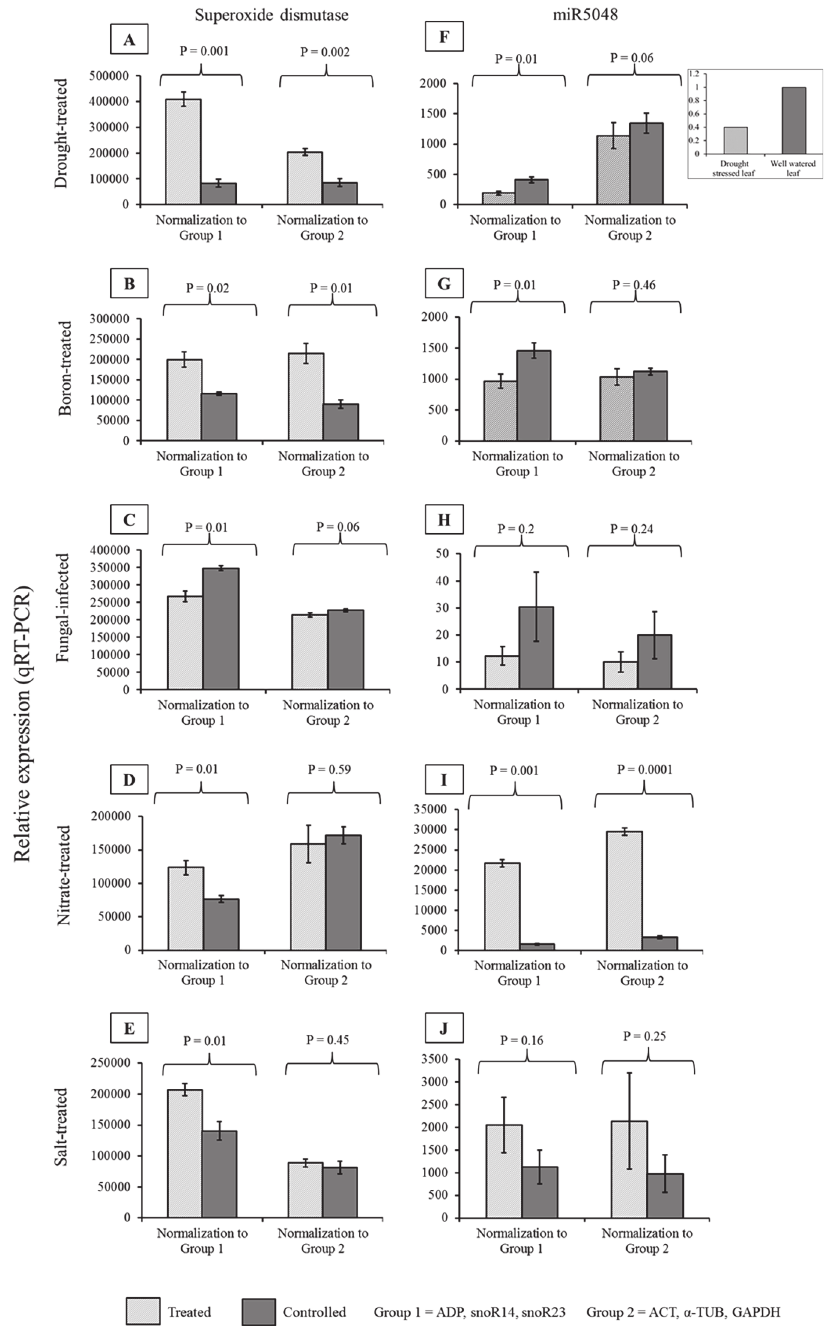
Fig 5. Validation of putatively stable reference genes. Comparison of relative expression of (A, B, C, D, E) SUPEROXIDE DISMUTASE (AK363344.1) and (F, G, H, I, J) miR5048 (MIMAT0020544) in drought-treated, boron treated, fungal infected, nitrate treated and salt treated samples and their respective controls by qPCR when normalized to group1 (a combined group of three stable reference genes; snoR14, ADP , snoR23) and group 2 (a combined group commonly used housekeeping genes; ACT , α -TUB , GAPDH ). The error bars indicate the standard deviation of the mean. Statistical analysis by t-test. (Inset in 5F) The relative expression of miR5048 from deep sequencing of drought-stressed and well-watered barley leaves. Reads per million (RPM) of 1 was the highest number of counts.